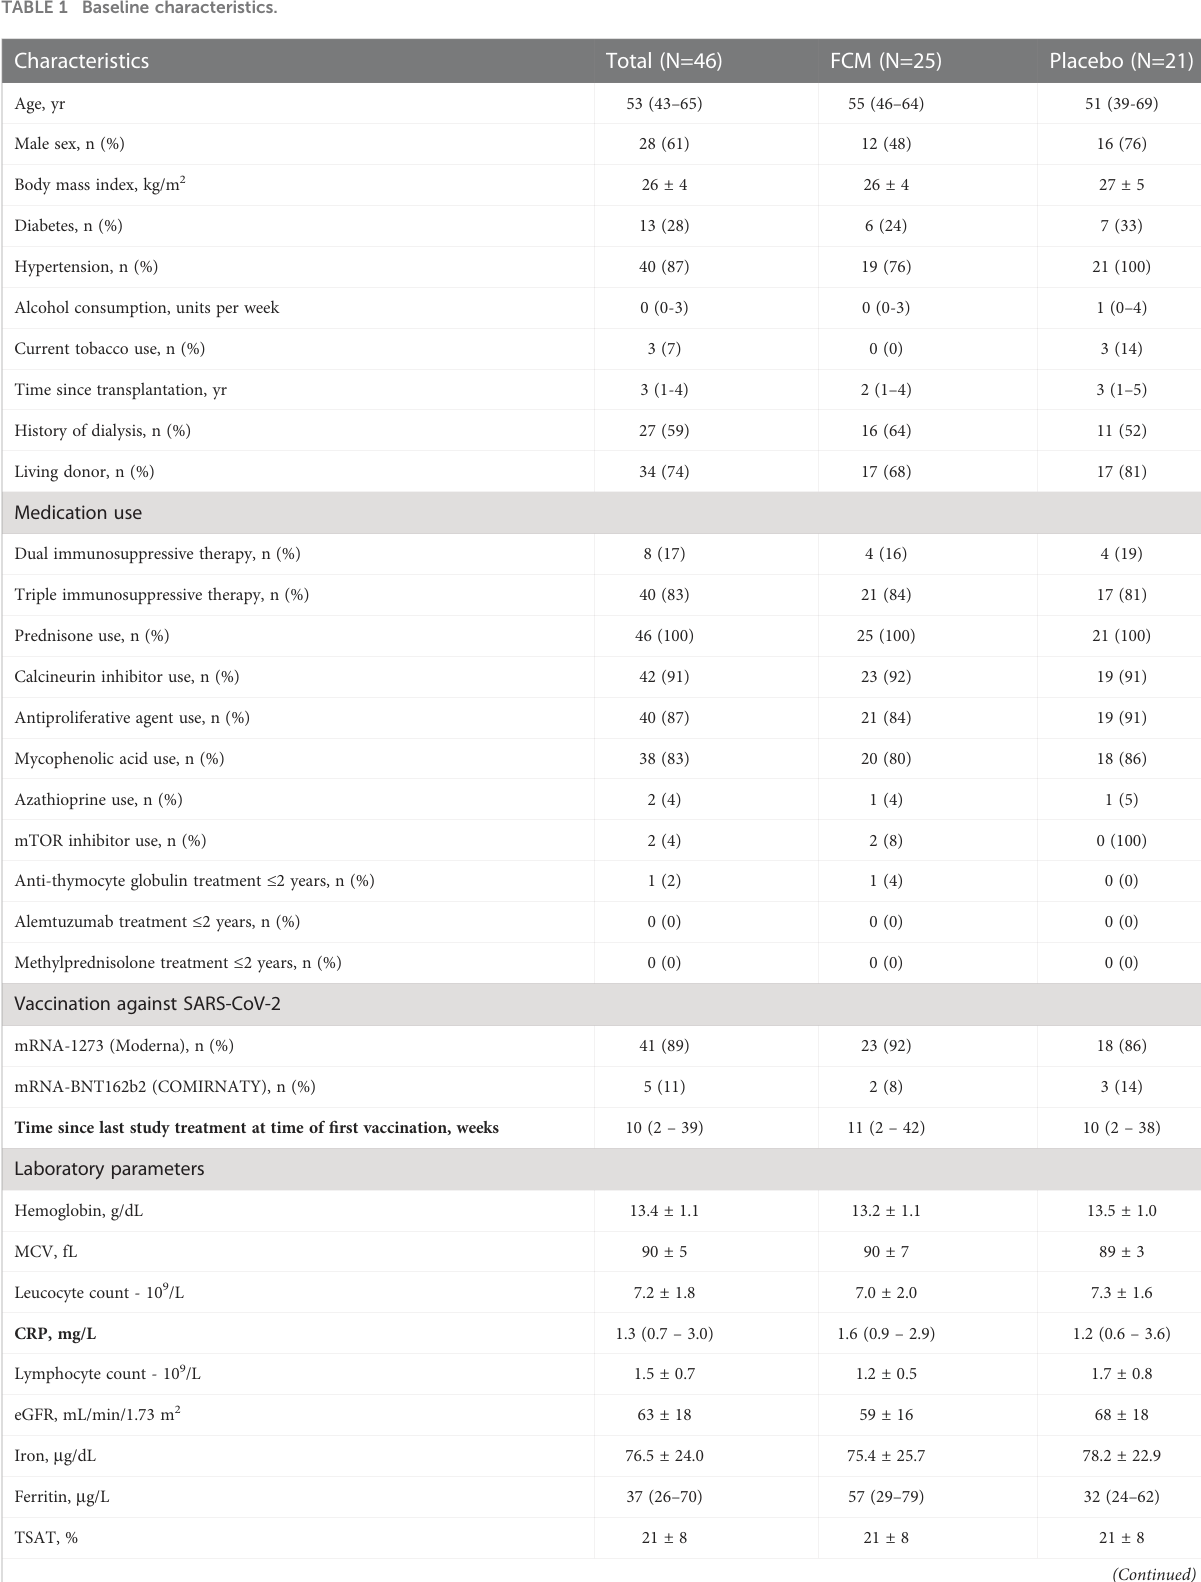
TABLE 1 Baseline